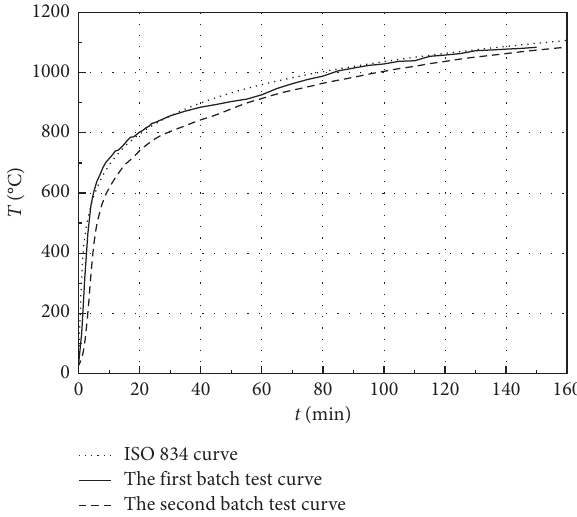
Figure 3: Temperature-fire curves of fire furnace.